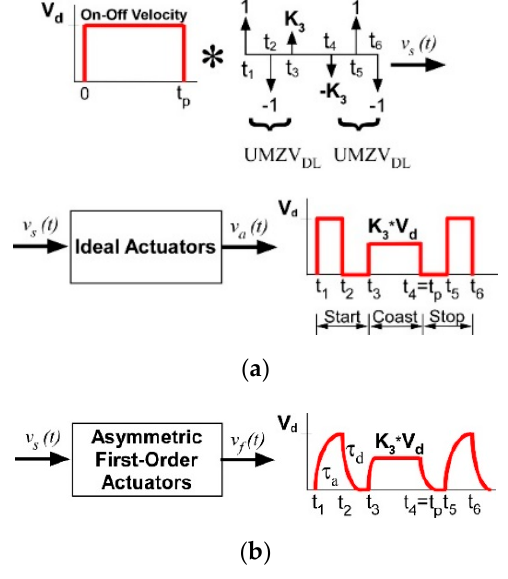
Figure 1. Effect of asymmetric first-order actuators. ( a ) UMZV DL shaped command; ( b ) Distorted Figure 1. E ff ect of asymmetric first-order command.